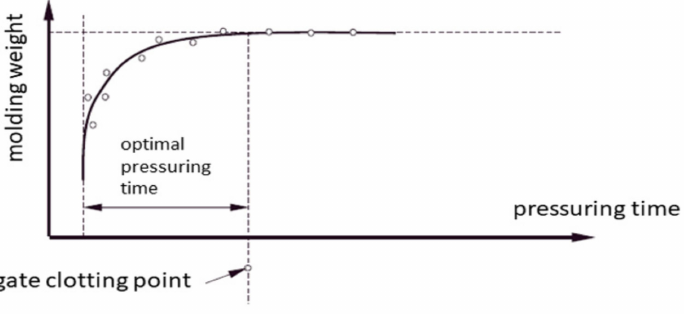
Figure 4. Weight method of determining the pressing time.